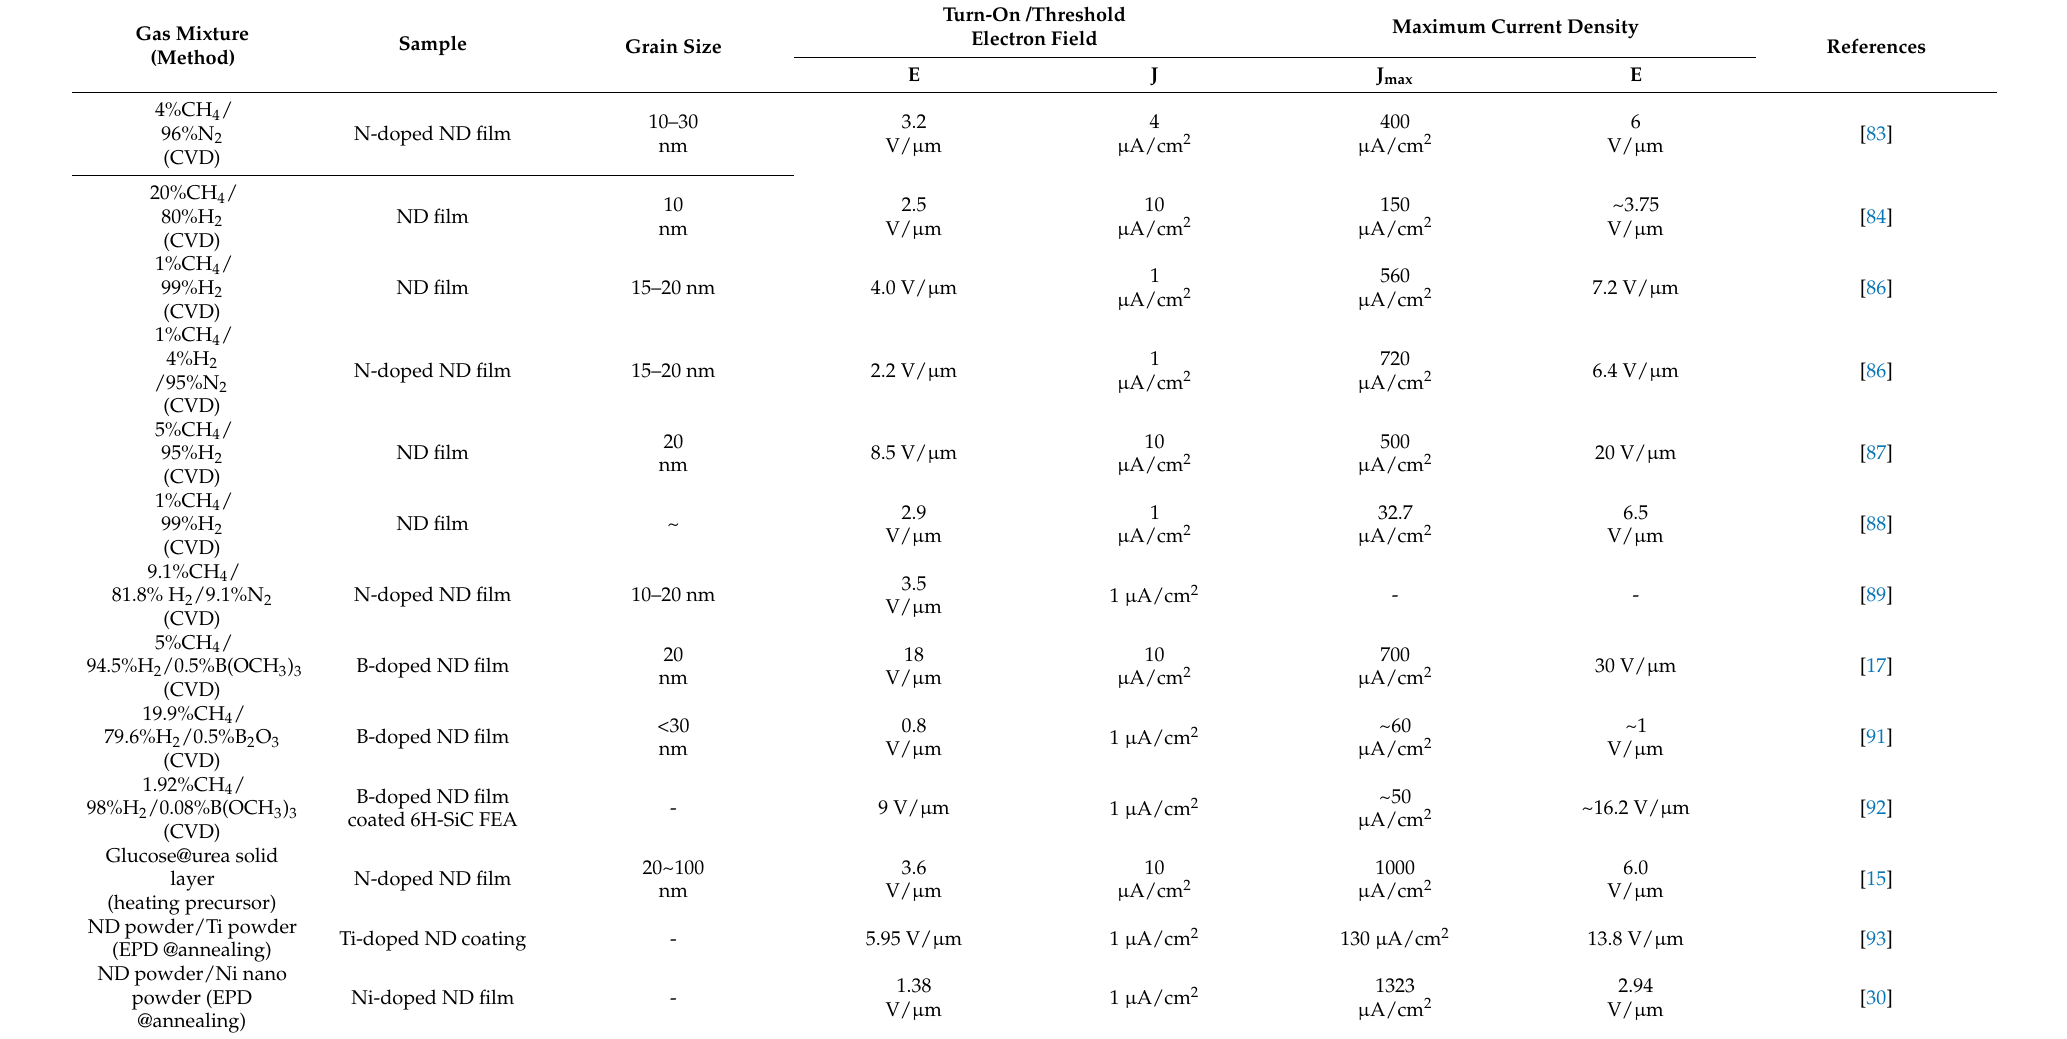
Table 2. The field emission properties of intrinsic/doping ND films in recent